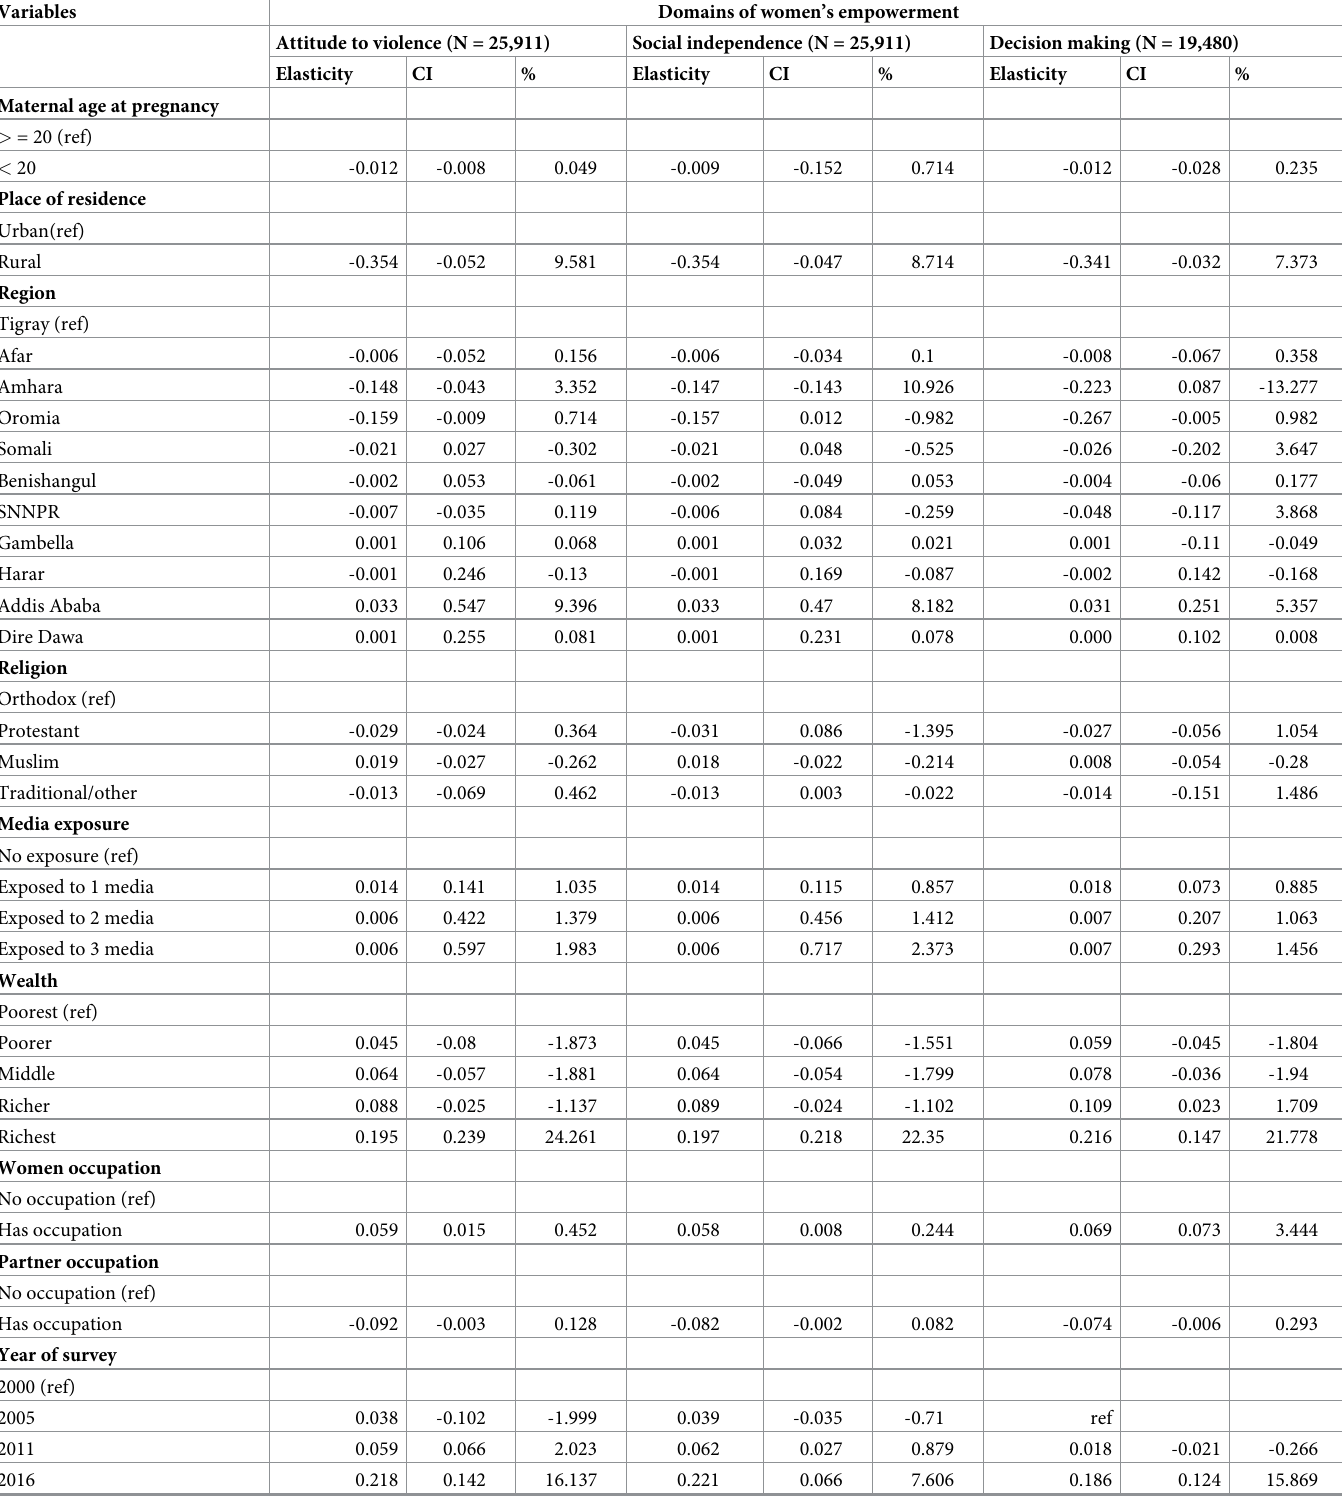
Table 4. Decomposition of the inequalities in the usage of at least four ANC visits by women’s empowerment, 2000–2016